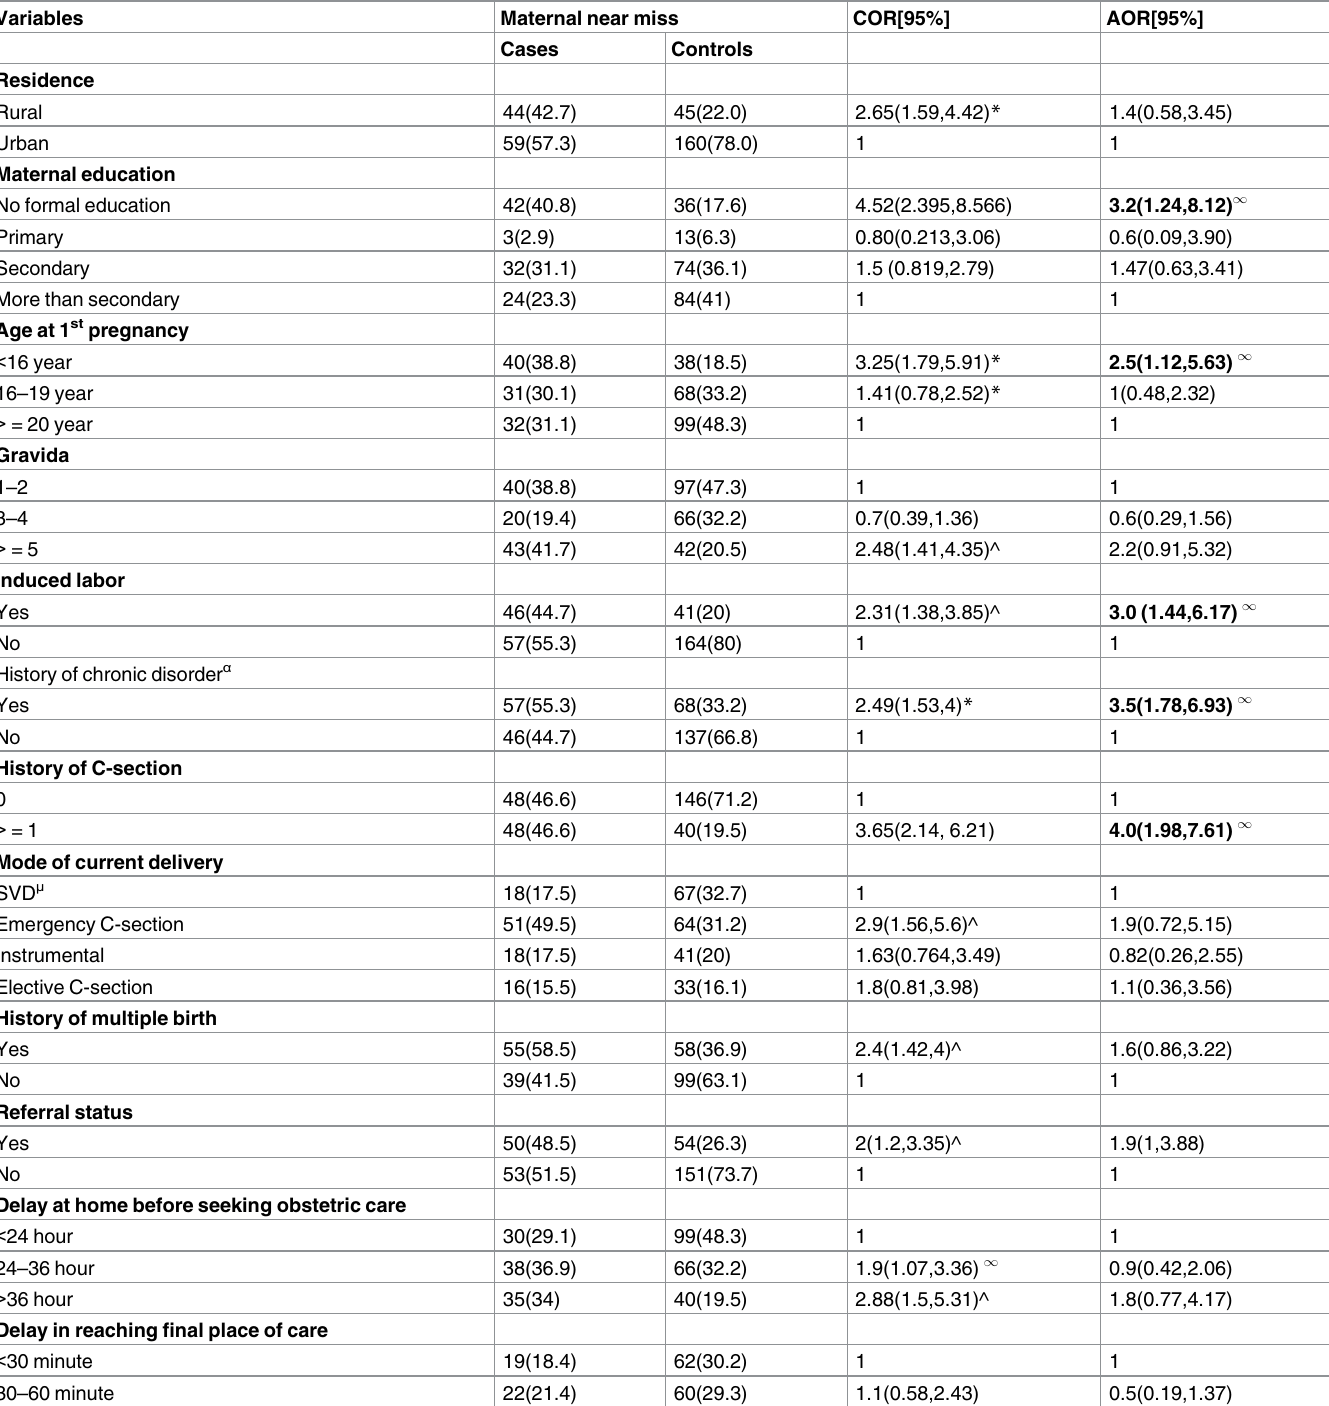
Table 5. Determinants of maternal near miss among mothers admitted in public hospitals, Tigray, Northern Ethiopia, 2016. (N =